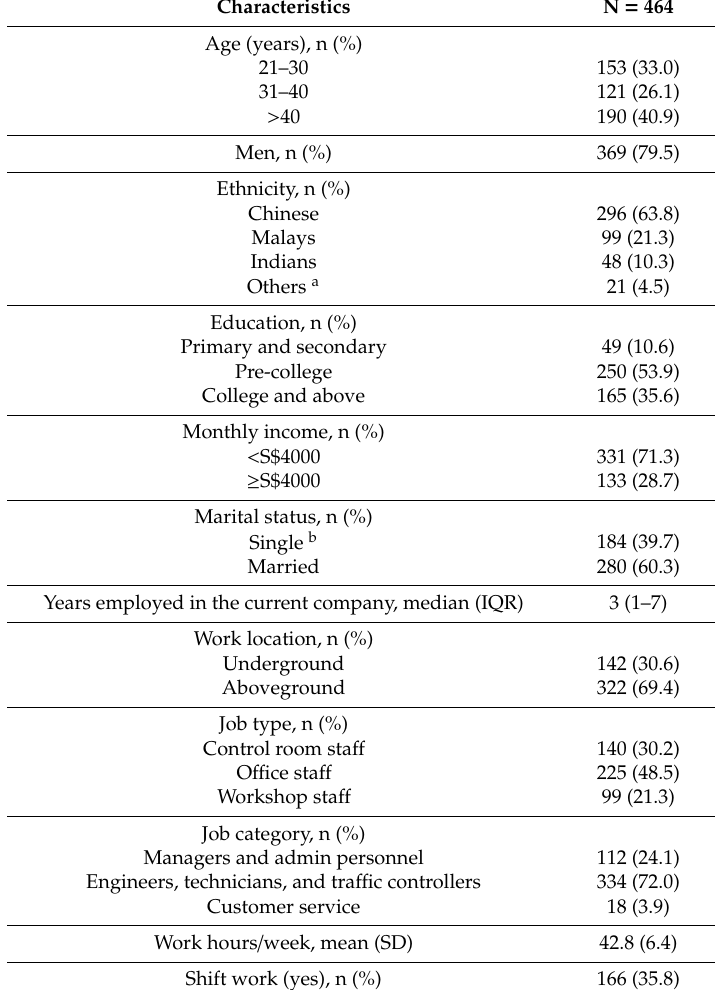
Table 1. Socio-demographic and work-related characteristics of the participants at